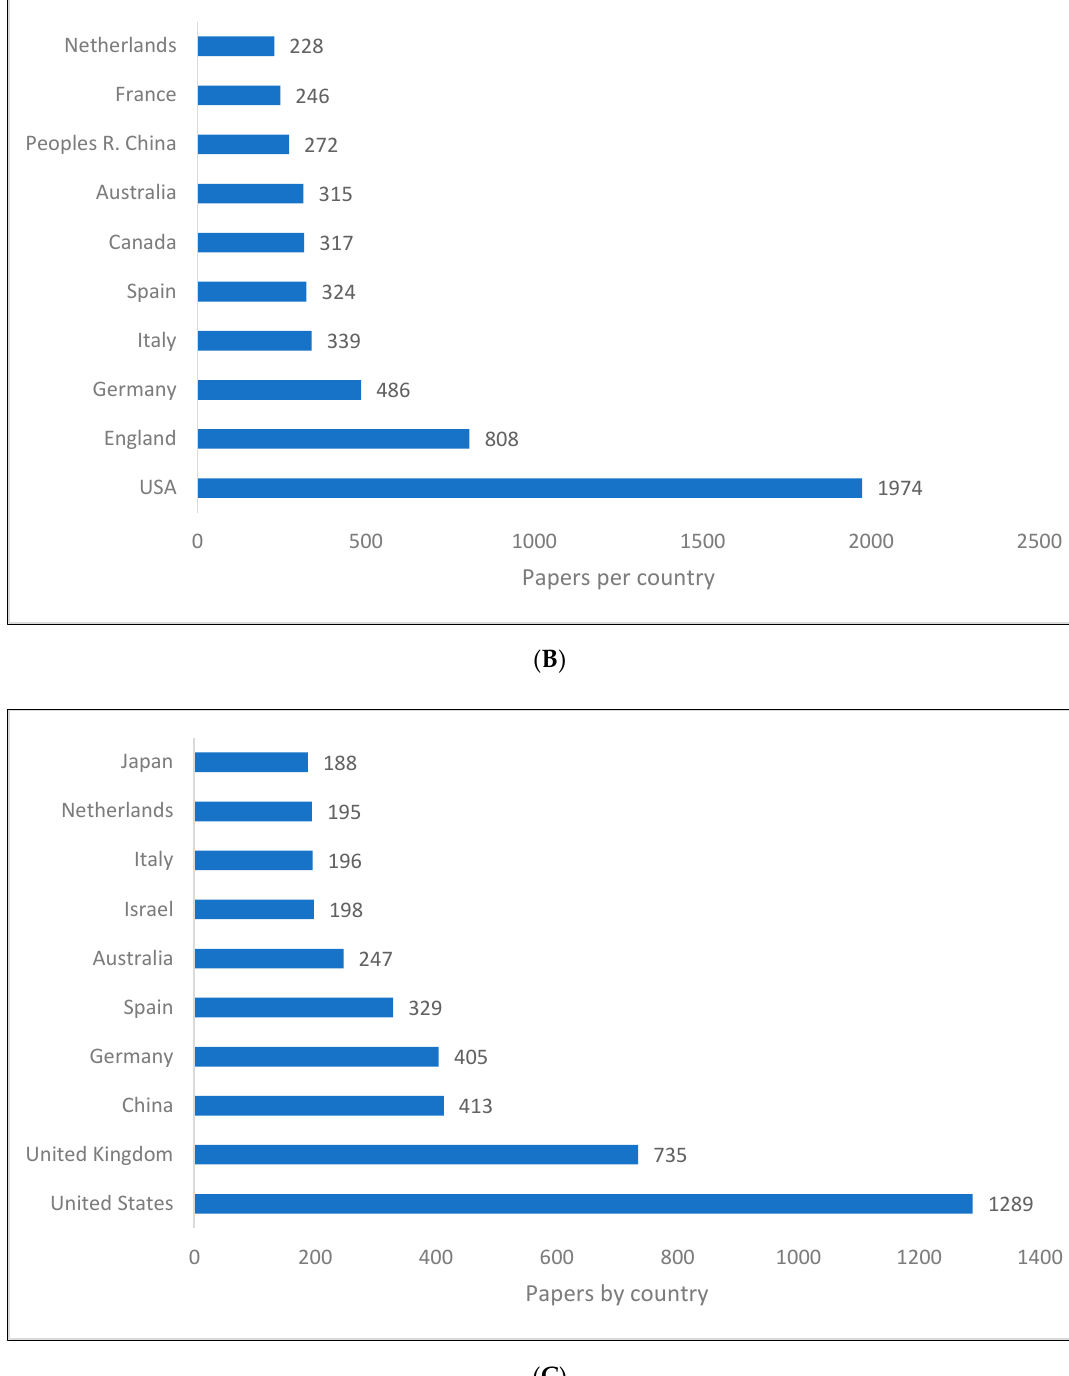
Figure 2. Pragmatics knowledge production size by country. ( A ) (Scopus). ( B ) (WOS). ( C ) (Lens).